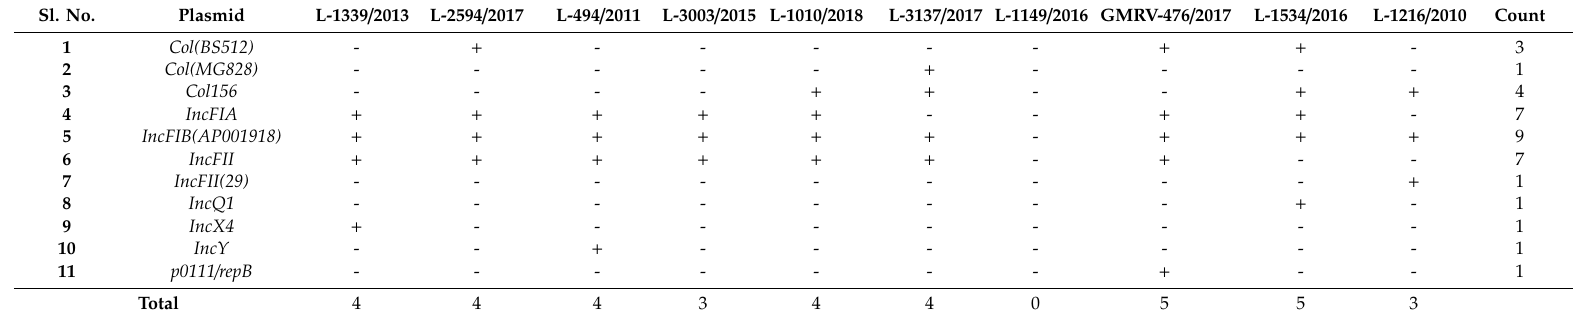
Table 4. Plasmids in the 10 ocular E. coli *